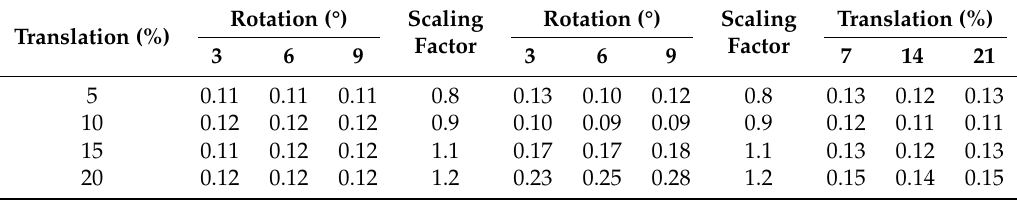
Table 13. Average BER of the proposed method for combination geometric distortion. The experiment was conducted on the synthesized right